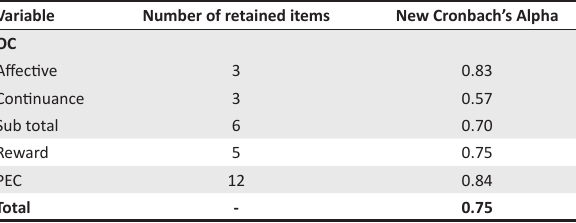
TABLE 2: Post reliability report.